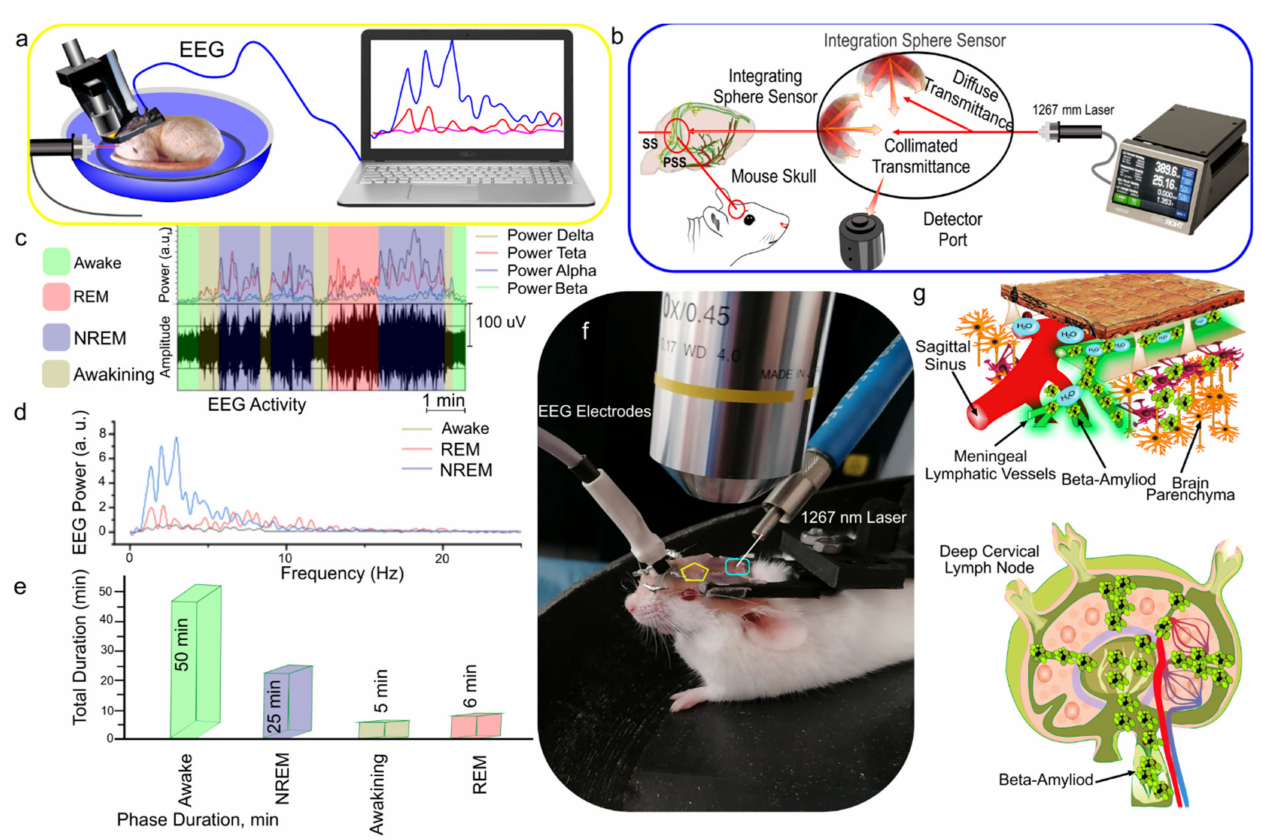
Figure 1. Schematic illustration of the design of the experiments: ( a ) EEG recording in the mouse; ( b ) schema of the laser effects on the dorsal part of the MLVs [40]; ( c ) changes in the power of the EEG signal in the delta, theta, alpha, and beta ranges; ( d ) spectrum of the EEG signal in three different states: wakefulness, REM, and NREM sleep; ( e ) average duration of wakefulness, REM, and NREM sleep; ( f ) representative image of simultaneous EEG recording and PS effects on the dorsal part of the MLVs of nonanesthetized mouse; ( g ) schema of the PS-mediated stimulation of the lymphatic clearance of FA β from the mouse brain via the MLVs into